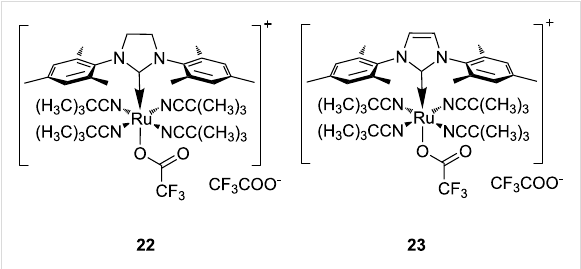
Figure 9: Photoactivated cationic ROMP